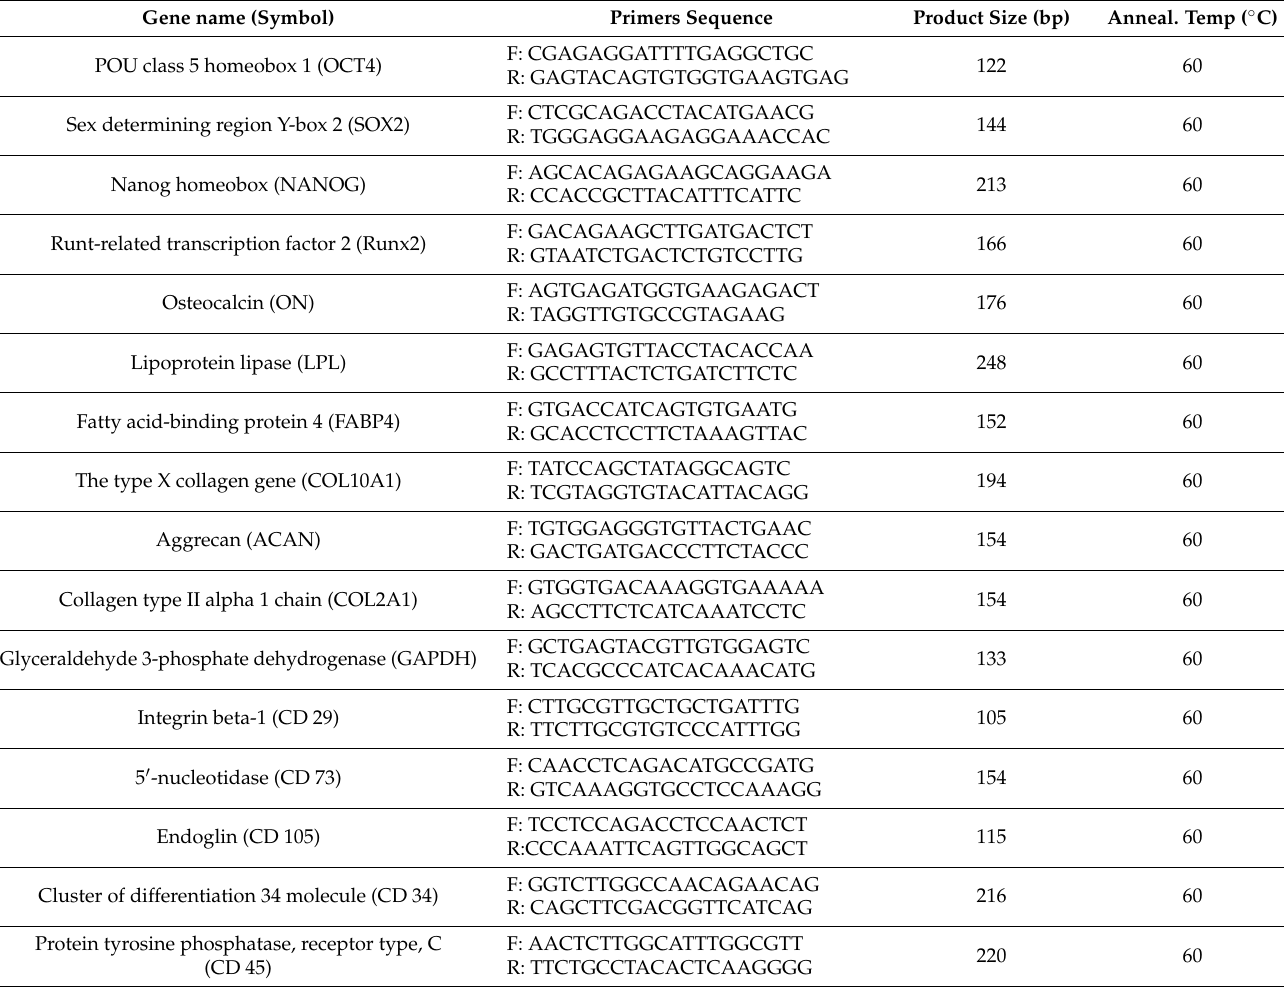
Table 1. Lists of camel primers used in RT-qPCR